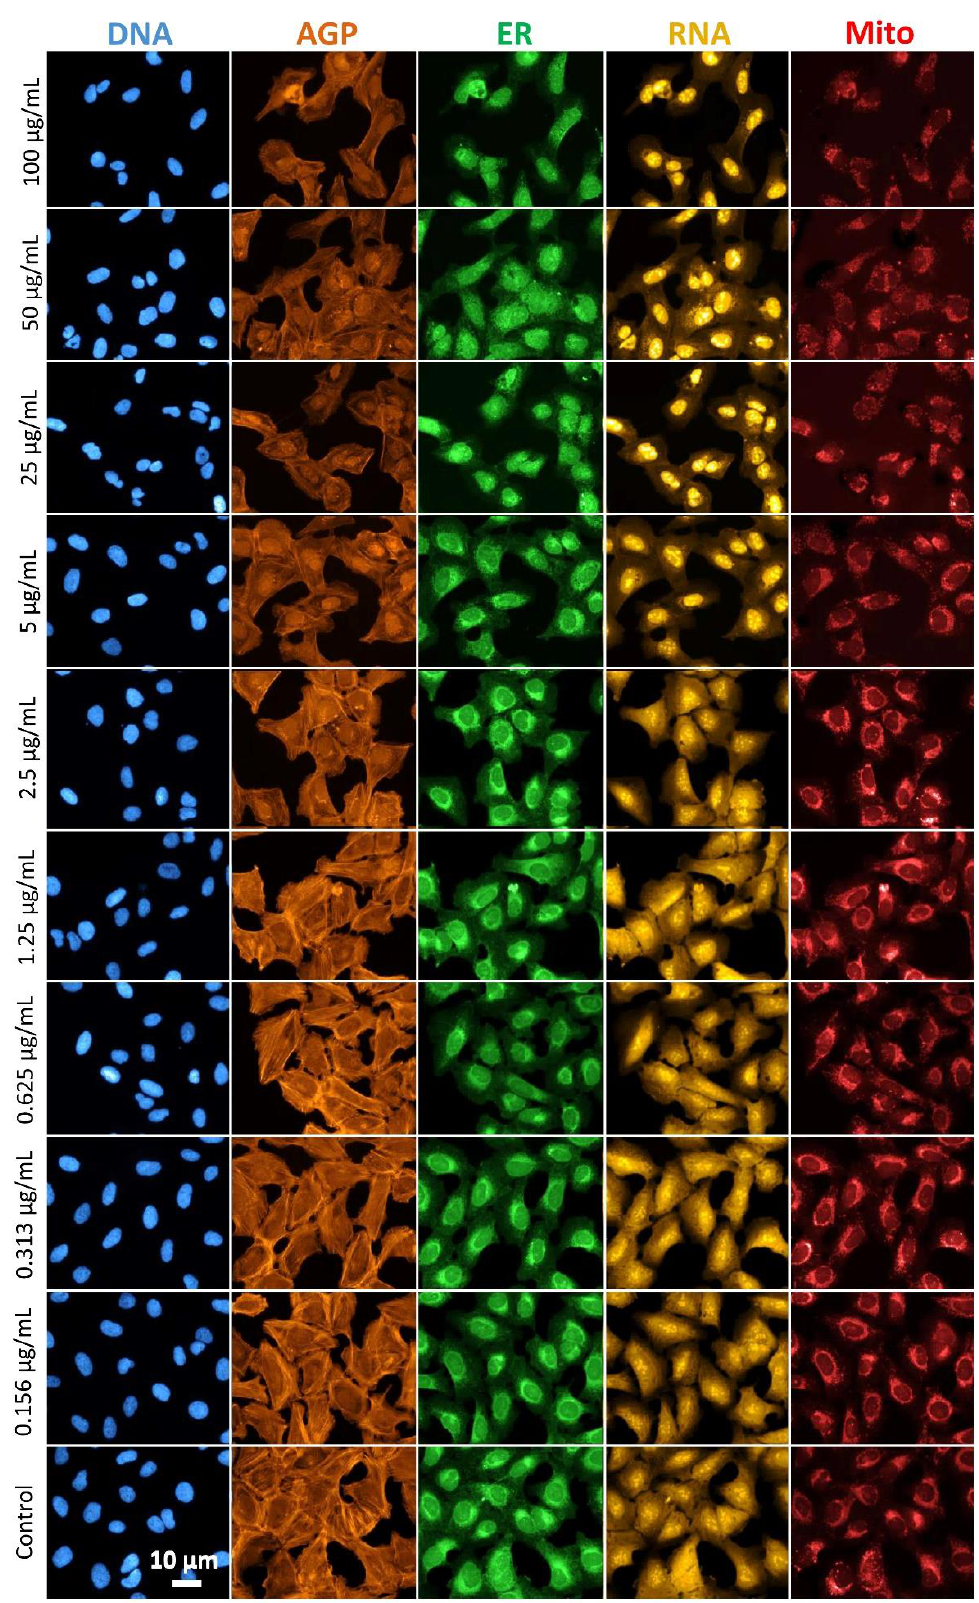
Figure 4. Cell Painting labelling patterns in the U-2 OS cells. Representative images of the control and cells exposed to 0.156, 0.313, 0.625, 1.25, 2.5, 5, 25, 50, and 100 µg/mL of the (nano)particles unintentionally emitted at the metal AM occupational settings (AMPs), live-labeled for the mito- chondria (Mito), fixed, permeabilized, and labeled with the remaining fluorescent probes for the